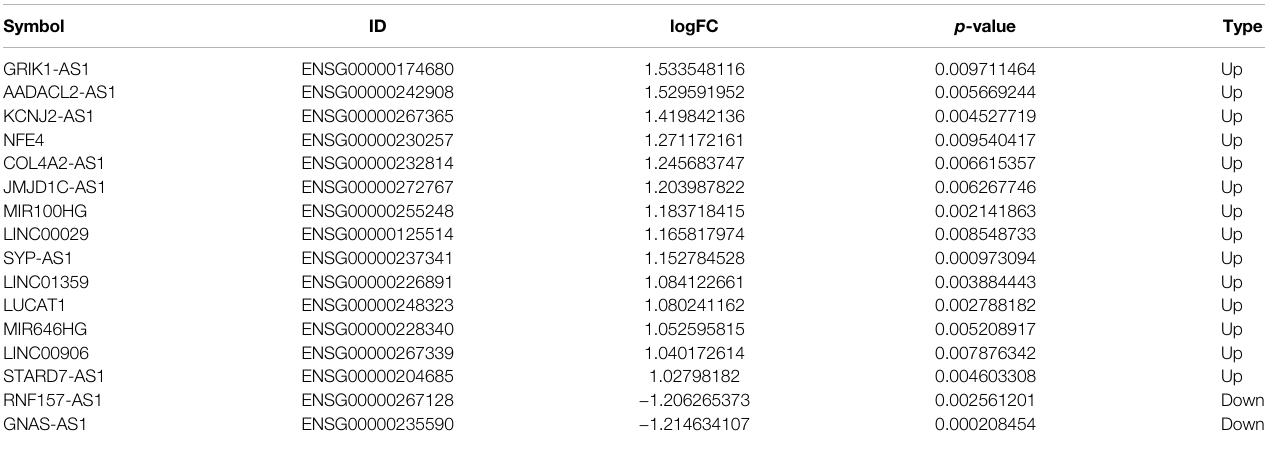
TABLE 3 | Differential expression of 16 OS-related DE-lncRNAs between normal and IDD groups. Symbol ID logFC p -value